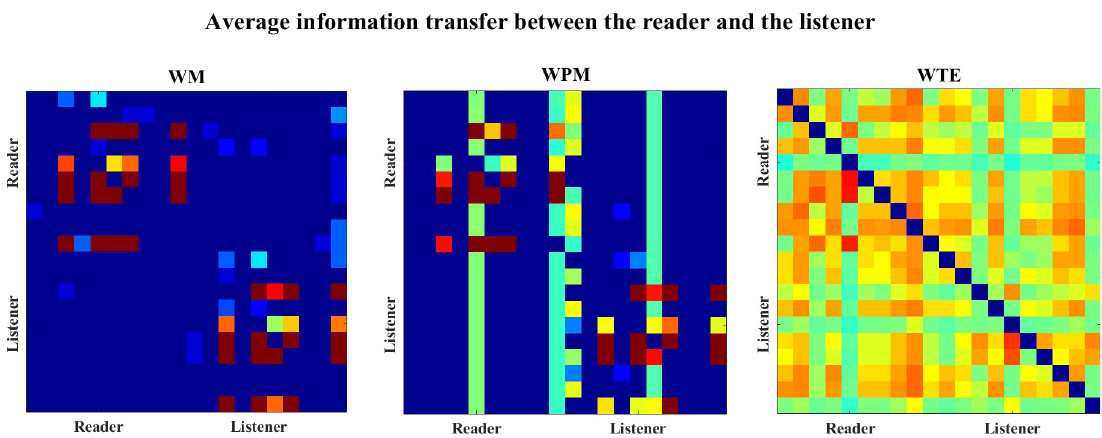
Fig 25. The color-map for the average information transfer between the reader and the listener. The color-graphs separately show the average WM (left), WPM (middle) and WTE (right) values for the 20 channel EEGs. For each lattice the directional inference is read from the row channel to the column channel. In the color-matrices, the diagonal blocks present the “intra-brain” information transfers within each participant, while the off-diagonal blocks present the “cross-brain” interactions across different participants.